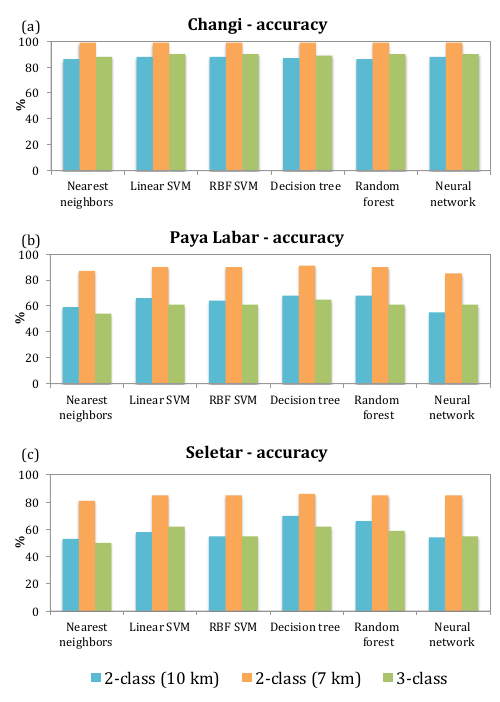
Figure 7. The testing accuracy in six machine learning algorithms for 2 two-class (7 or 10km visibility as a breakpoint) and 1 three- class classifications haze prediction in (a) Changi, (b) Paya Lebar, and (c)